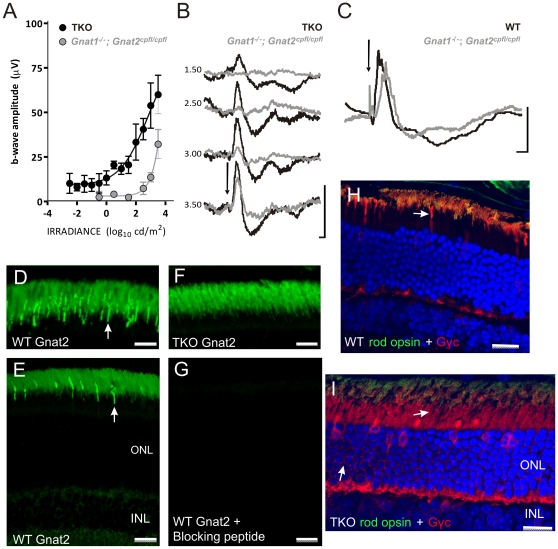
ERG responses in Gnat1−/−;Gnat2cpfl3/cpfl3 mice.
A, Comparison of b-wave amplitude of scotopic ERG in TKO and Gnat1−/−;Gnat2cpfl3/cpfl3 mice (mean±SEM; n = 5 for each group). B, Representative scotopic ERG traces from TKO and Gnat1−/−;Gnat2cpfl3/cpfl3 mice recorded in response to white flash stimuli (arrow depicts flash onset; scale bar =  50 ms (x-axis), 25 µV (y-axis); numbers to left are stimulus irradiance in log cd/m2). C, Representative traces for light-adapted ERGs in wildtype and Gnat1−/−;Gnat2cpfl3/cpfl3 mice (arrow depicts flash onset; scale bar  = 50 ms (x-axis), 25 µV (y-axis)). Immunocytochemistry for Gnat2 using an anti-Gαt2 antibody in WT retina (D-E) revealed strong immunoreactivity in cones (arrows) with a lower level of staining found in rods. In TKO retina (F), staining in cones was absent, while immunoreactivity in rods persisted, even though these mice lack Gnat1, the most likely target of any cross-reactivity for this antibody. Pre-absorption with blocking peptide abolished staining in both rods and cones (G). Similarly, immunoreactivity for the γ subunit of cone transducin was detected in both cones and, to a lesser extent, rods of WT (H; arrow points to cones) and TKO (I; arrows point to rods) retinas. In WT retina there was a strong signal in cone outer segments, which was displaced to inner segments in TKO mice. Confocal settings were identical for images shown in D&F, E&G and H&I to facilitate comparison. Scale bars: D&F 10 µm, all others 20 µm.